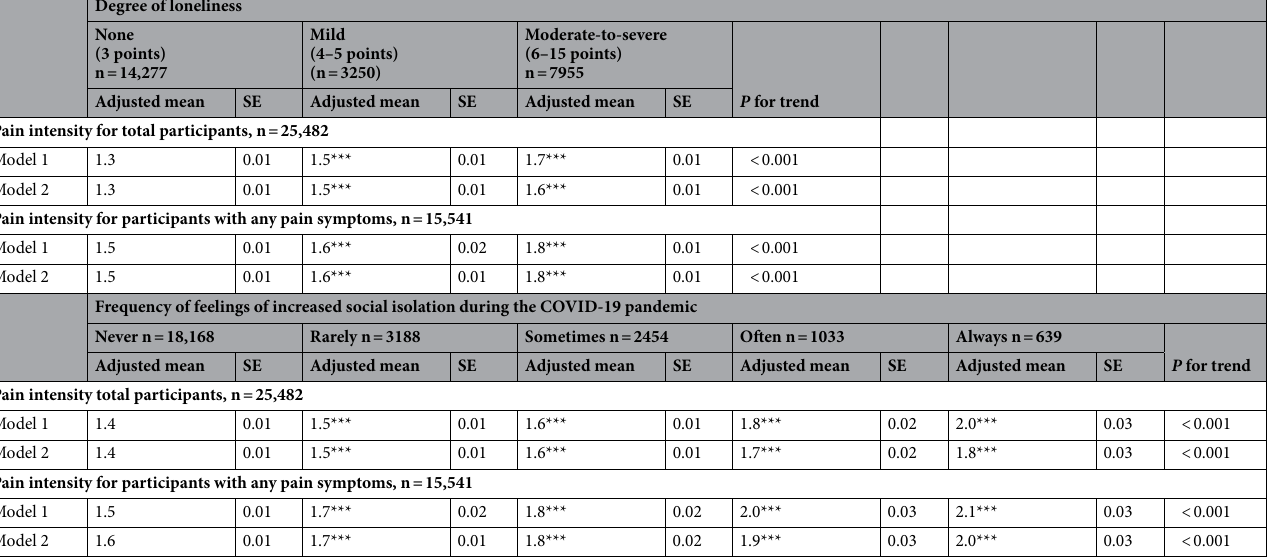
Table 3. The association of loneliness and a feeling of increased social isolation with pain intensity. Model 1: Adjusted for age and sex. Model 2: Adjusted for age, sex, educational level, marital status, living alone, employment status, equivalized income, smoking status, alcohol consumption, physical activity, sleep duration, history of depression, and history of mental illnesses other than depression. COVID‑19 coronavirus disease 2019, OR odds ratio, CI confidence interval. Loneliness was measured using the Japanese version of the University of California, Los Angeles Loneliness Scale (Version 3), Short Form 3-item assessment tool. Pain symptoms were headache, neck/shoulder pain, upper limb pain, low back pain, leg pain, or the presence of chronic pain. P values were calculated to compare participants who without loneliness / did not feel increased social isolation during the COVID-19 pandemic at all to those in the other categories using the analysis of covariance with Dunnett’s test. *** p < 0.001. n =